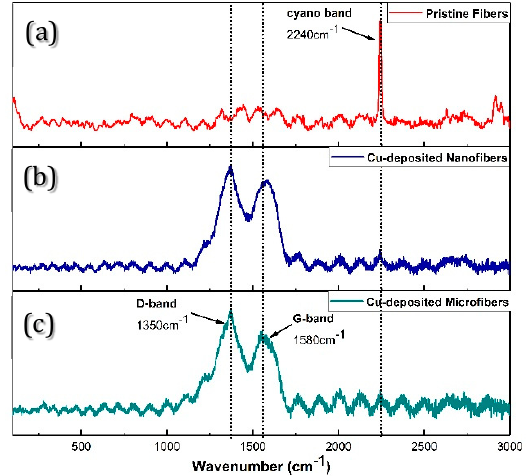
Figure 7. Raman spectra of PAN fibers. ( a ) Pristine fibers. ( b ) Nanofibers after copper nanocube deposition. ( c ) Microfibers after deposition.